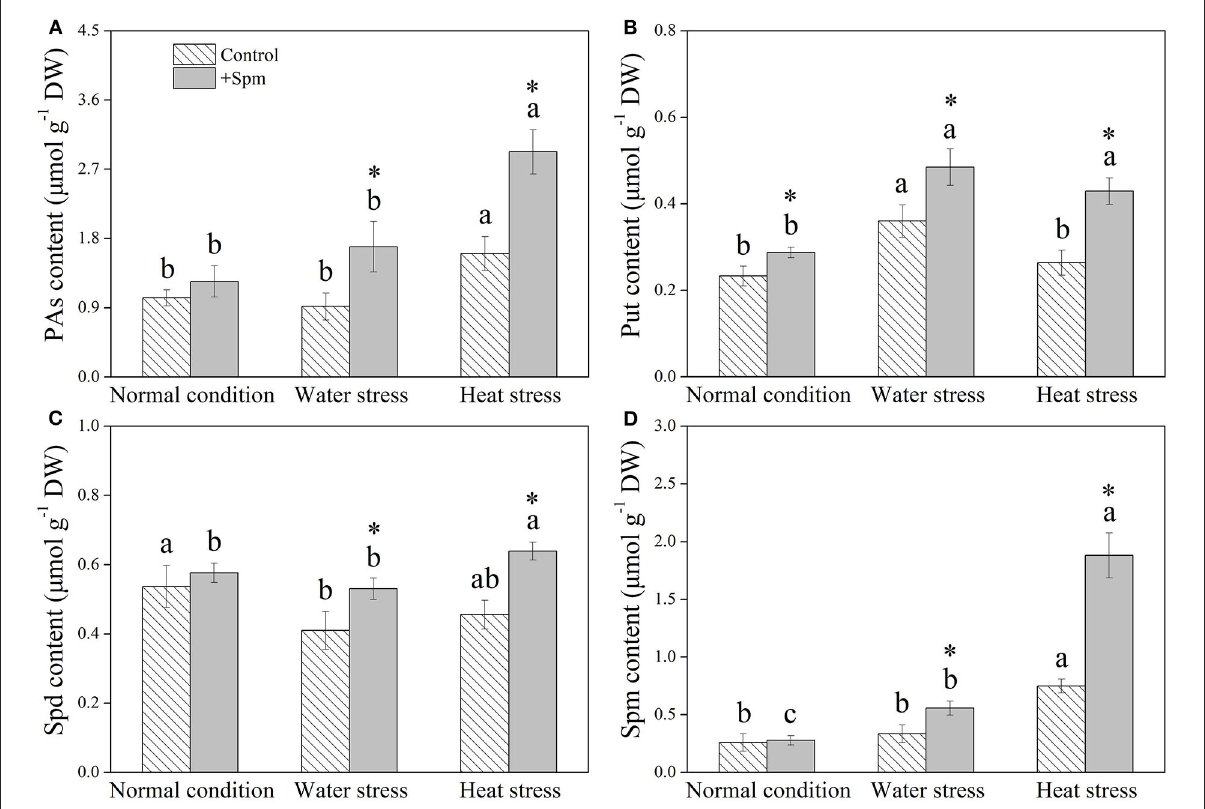
FIGURE1 Changes in endogenous (A) polyamines (PAs), (B) putrescine (Put), (C) spermidine (Spd), and (D) spermine (Spm) in response to Spm application under different conditions. Vertical bars indicate ± SE of mean ( n = 4). Different letters above striated or gray columns indicate significant differences for a particular treatment (control or + Spm) for comparison across the normal condition, water stress, and heat stress; the asterisk “*” indicates significant differences between the control and the + Spm treatments under one particular condition (normal condition, water stress, or heat stress) based on LSD ( P < 0.05). Total PA content was calculated by the sum of Put, Spd, and Spm